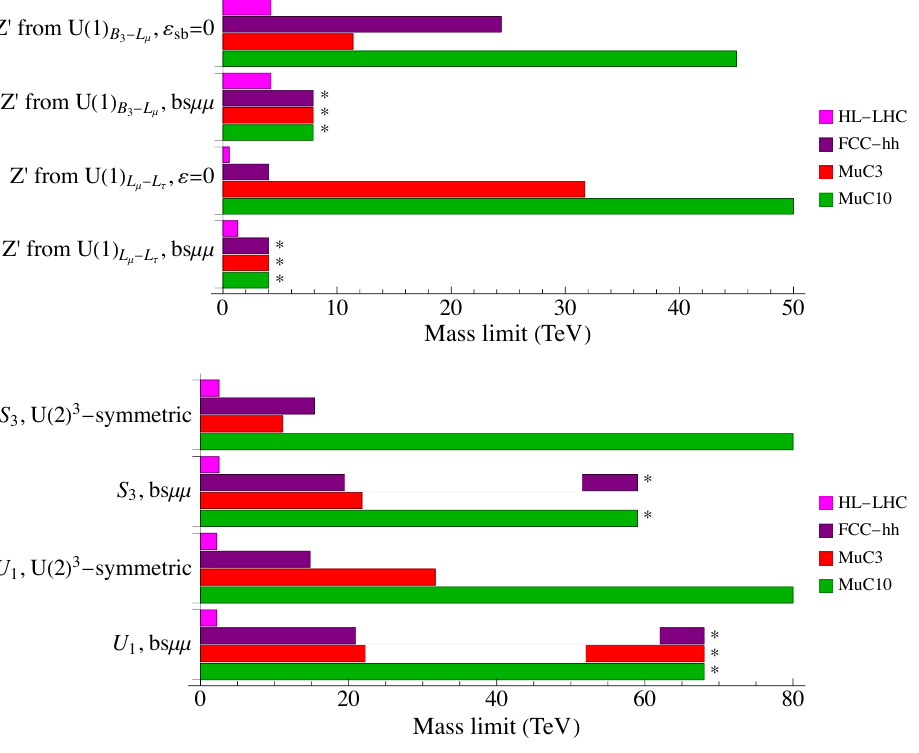
Figure 17 . Comparison of the discovery reach of future colliders for the different models discussed in this work. The corresponding couplings ( g Z 0 or λ bµ ) are set to 1 . We denote with an asterisk cases where the reach exceeds the perturbativity limit or meet any other relevant bound (e.g. from meson